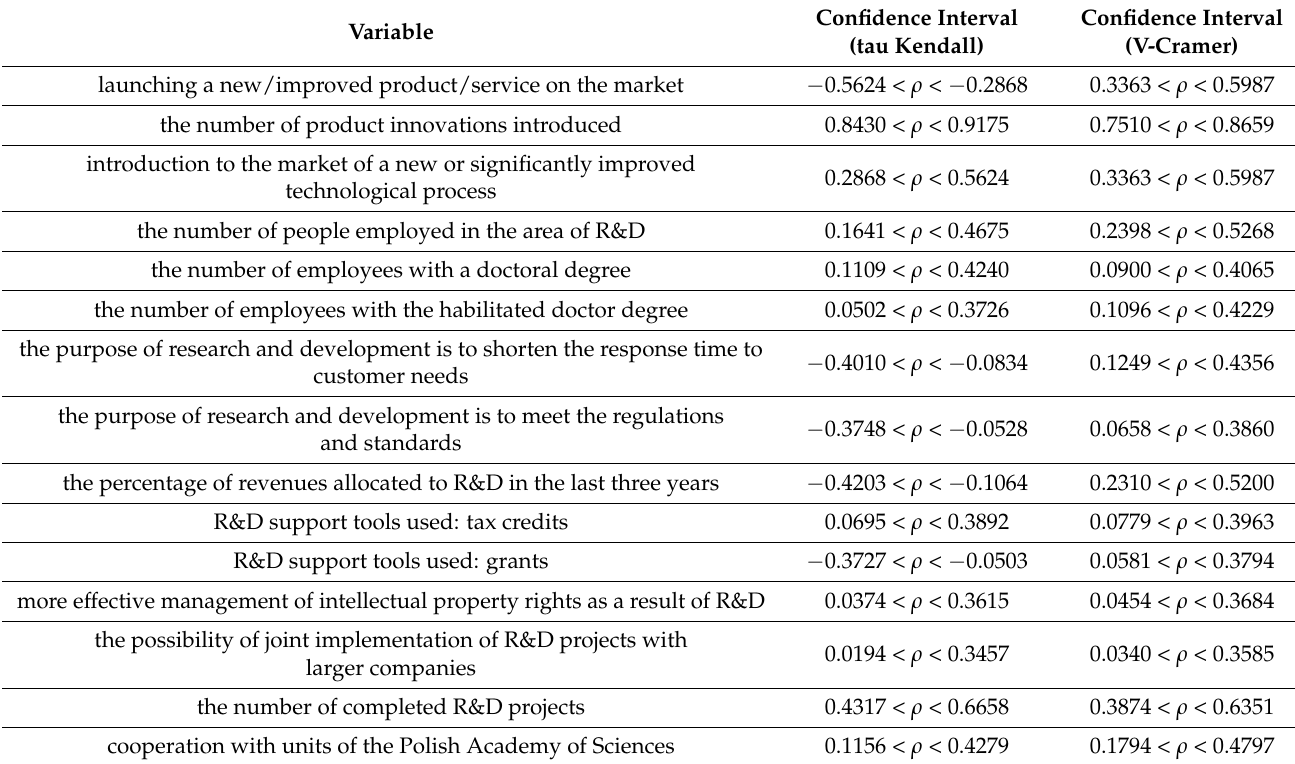
Table 3. Confidence intervals for the correlation